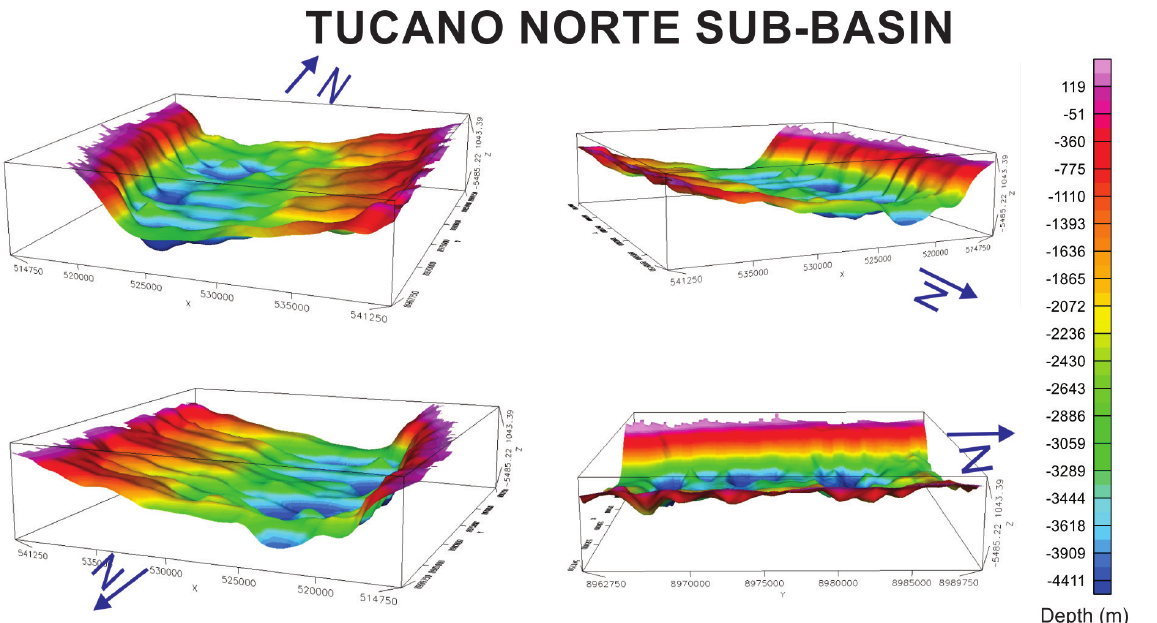
Figure 8. Three-dimensional framework of the Tucano Norte Sub-basin study area. The model indicates, similar to the Jatobá Basin, the presence of small horsts and a general semi-graben shape, but with a failed edge to the west and tailings in the study area of approximately 5100 metres.